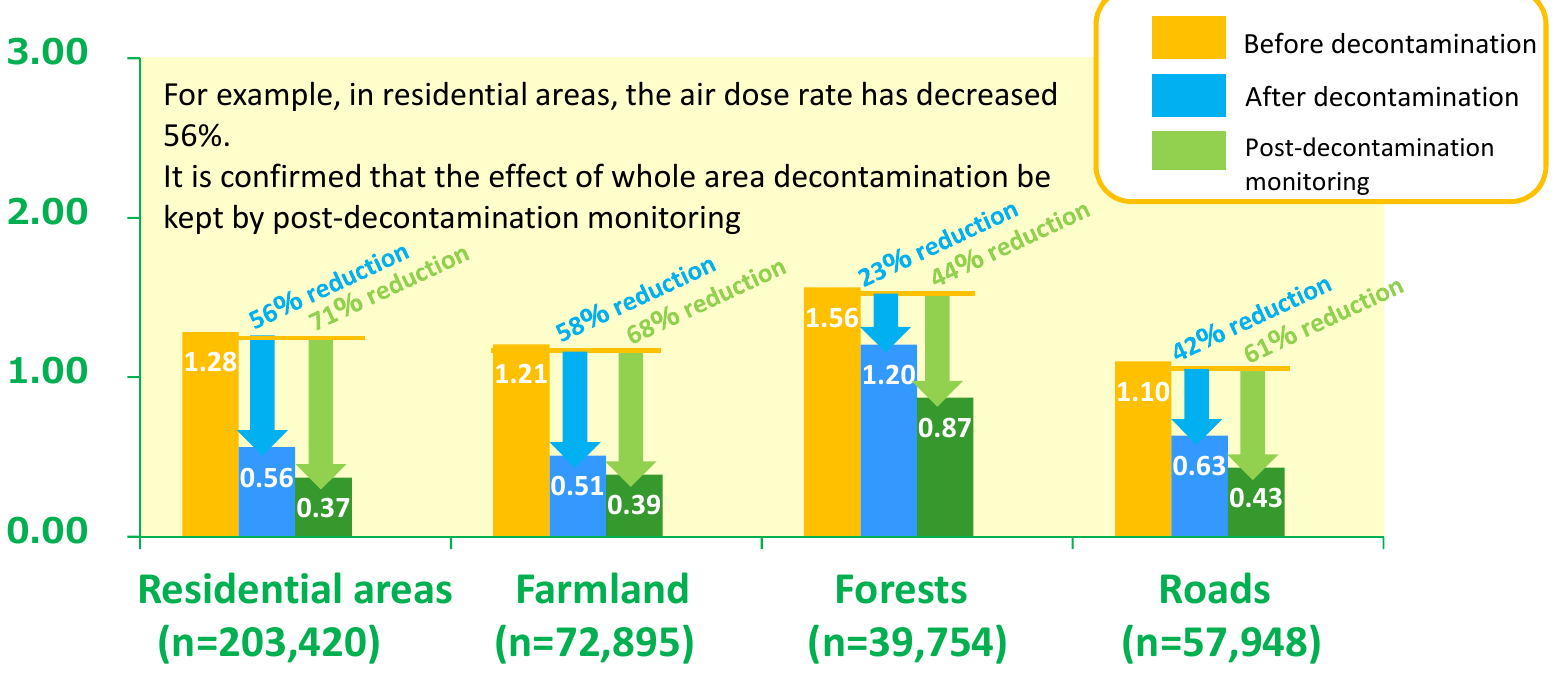
The chart shows the air dose rate average in each category (aggregated data of measuring